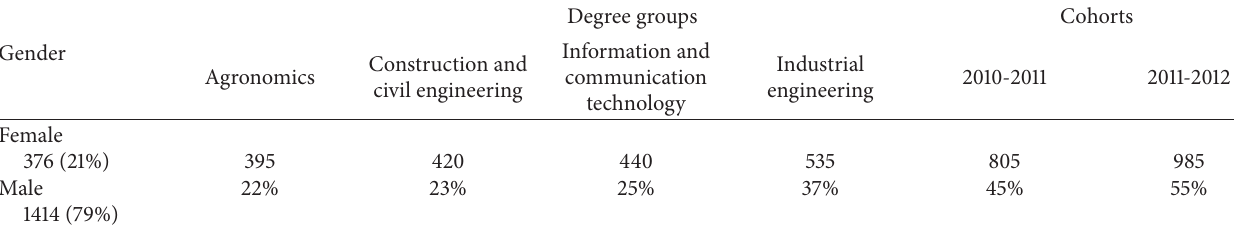
Table 2: Samples of UPV engineering students in 2010/2011 and 2011/2012.